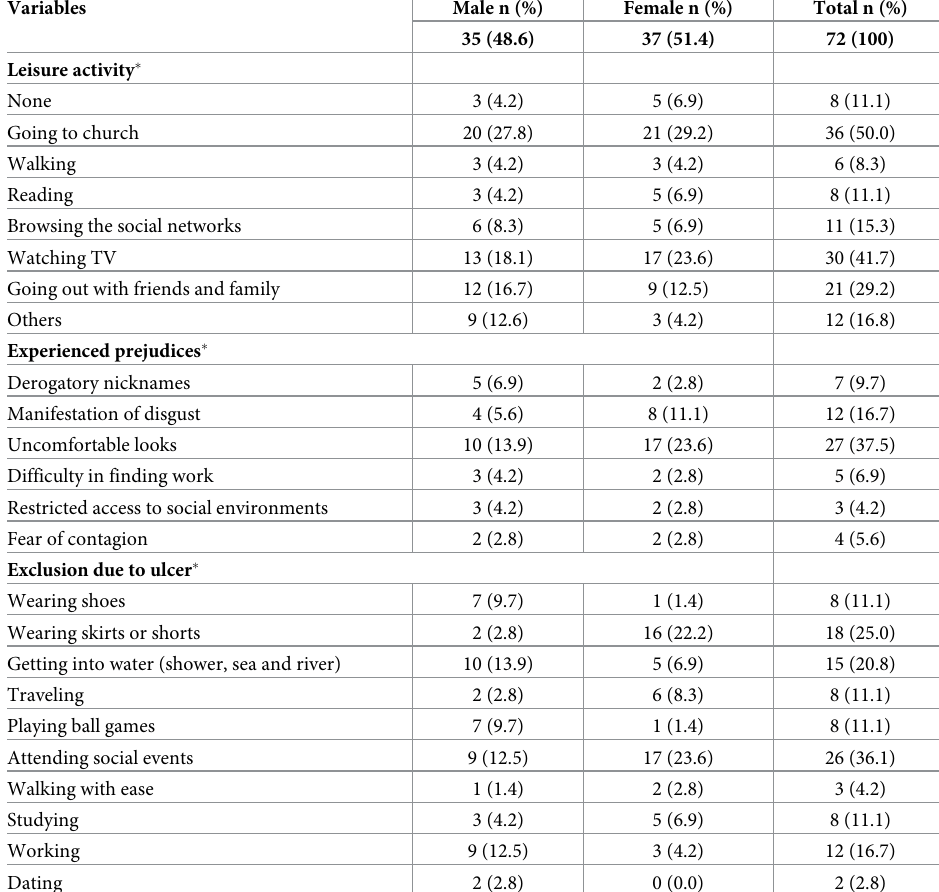
Table 3. Data regarding the variables: Leisure activities, forms of prejudice, and activities not performed because of ulcer, by sex (n = 72).